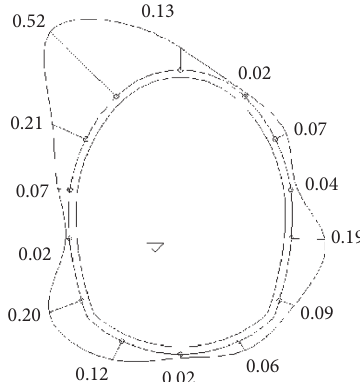
Figure 10: Distribution of surrounding rock pressure on the cross-section C (unit: